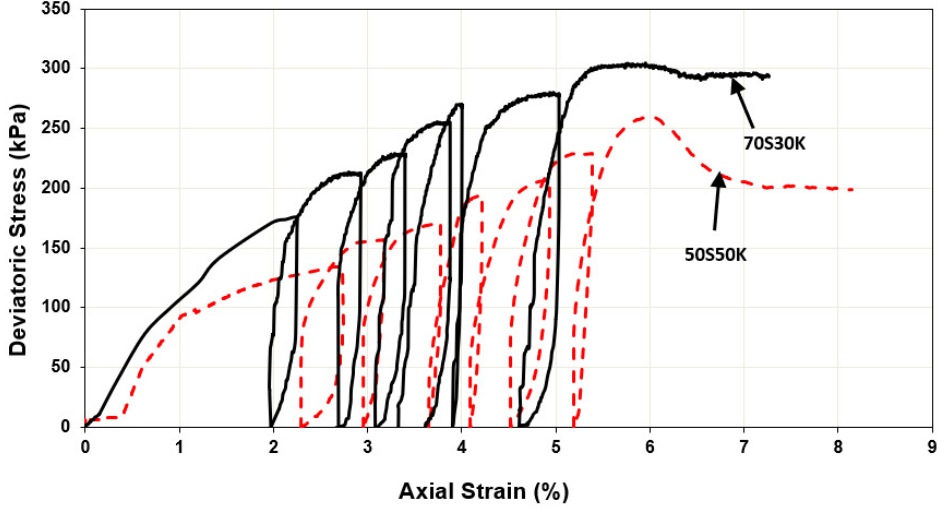
Figure 11. Deviatoric stress against axial strain circle of soil specimens 70S30K and 50S50K from unsaturated shear strength test.